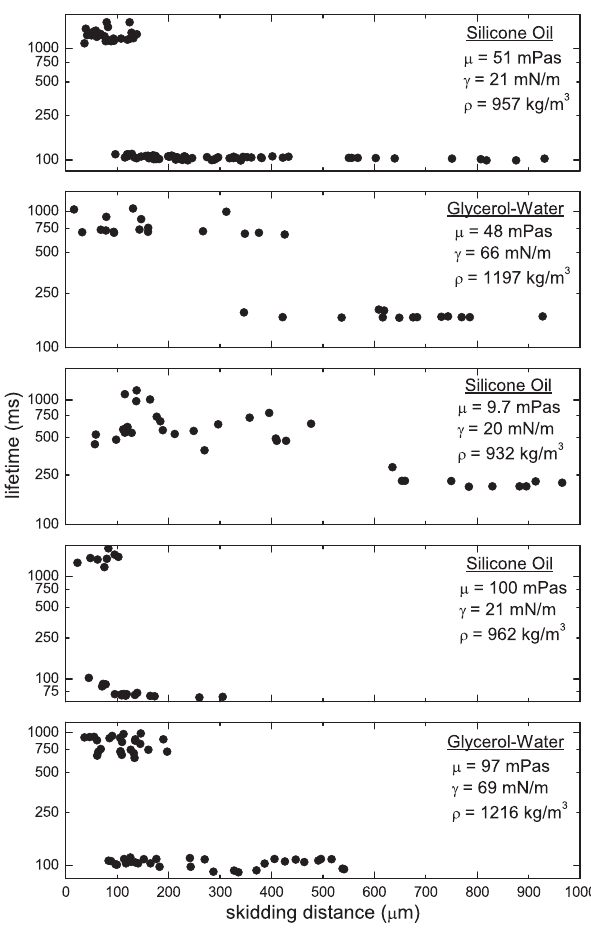
FIG. 18. Droplet lifetime versus skidding distance for various liquids with different viscosities, surface tensions, and impact velocities. The same result reproducibly appears: there always exist two distinct states with long and short lifetimes. The impact velocities are, from top to bottom, 0.32, 0.13, 0.13, 0.36, and 0 . 10 m = s,